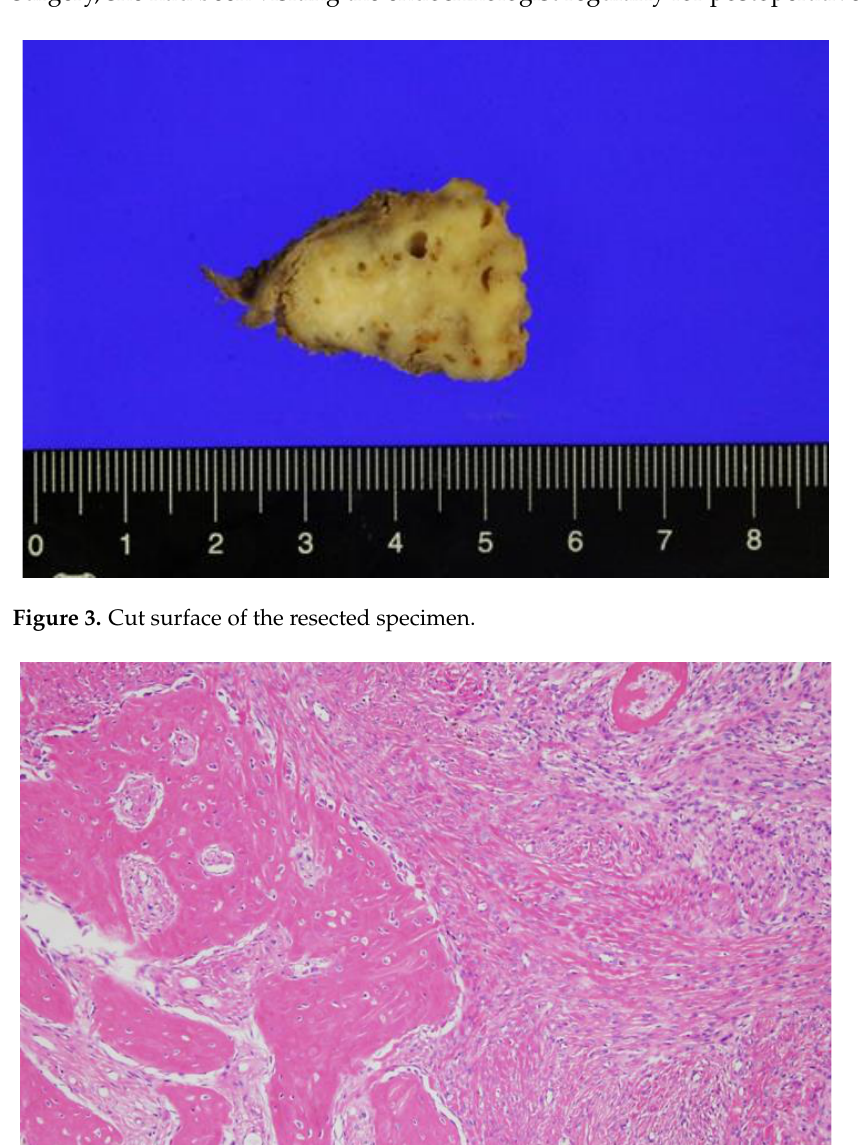
Figure 4. Microscopic findings of phosphaturic mesenchymal tumor. Woven bone elements and an incomplete rim of membranous ossification were observed.